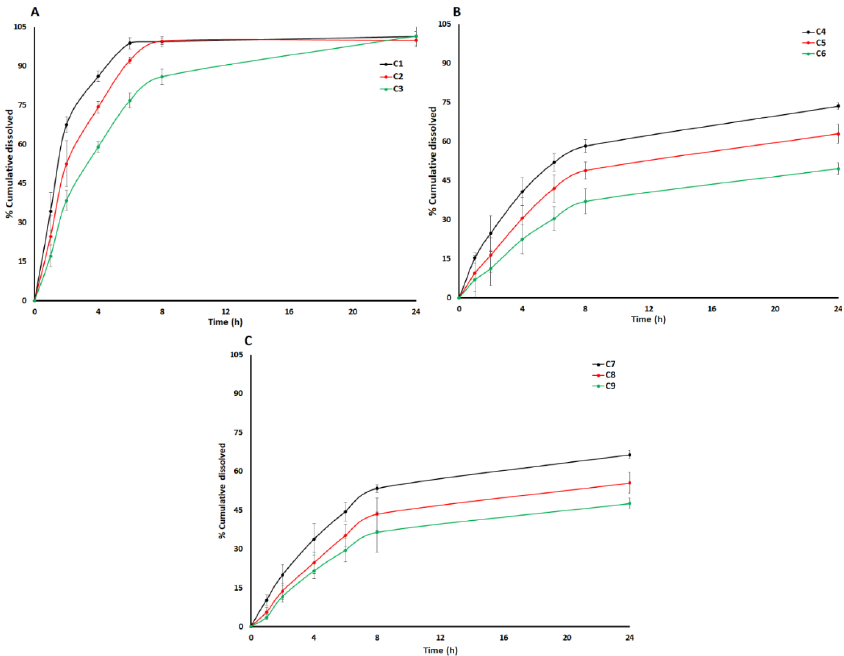
Figure 3. Dissolution profiles of tablet coated with CAB 171-15 / C-A-P at approximately ( A ) 5%, ( B ) 7.5%, and ( C ) 10% weight gain.